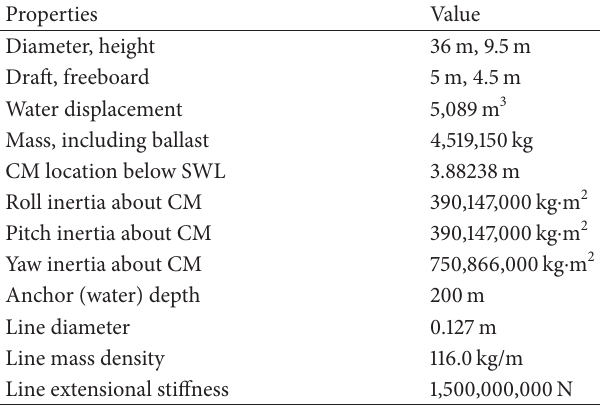
Table 2: NREL 5 MW platform